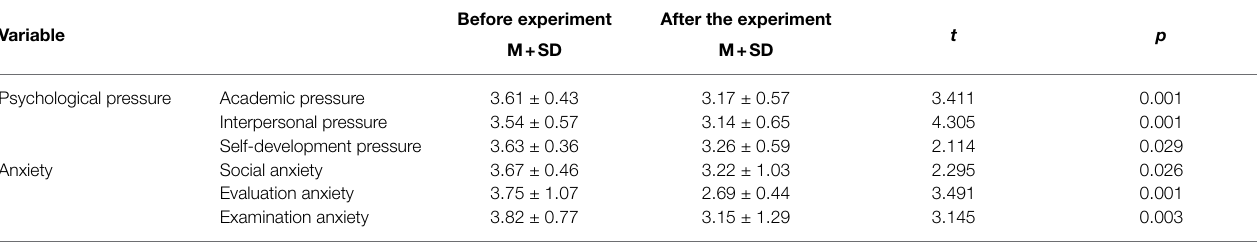
TABLE 4 | Difference analysis of overall psychological pressure and anxiety before and after the experiment.